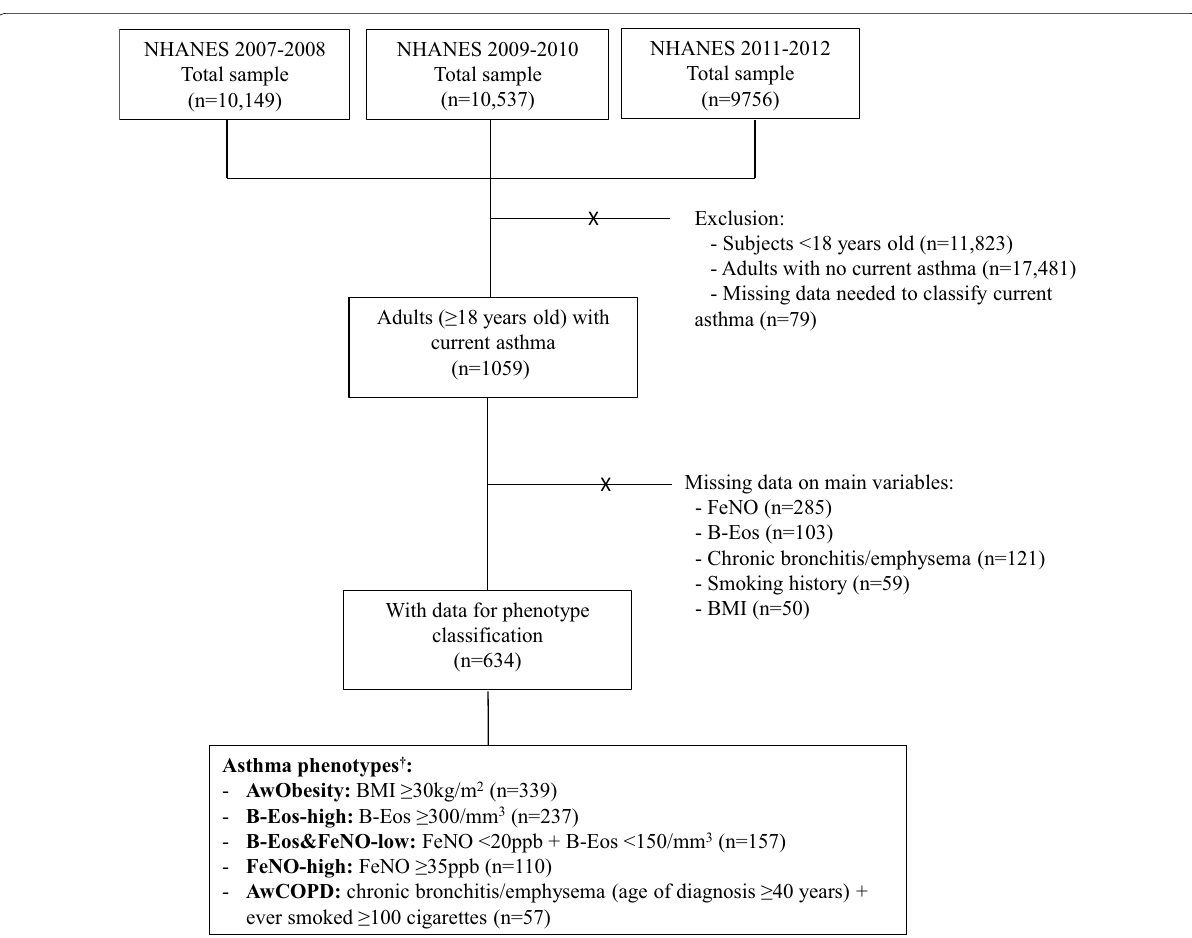
Fig. 1 Flowchart of the study analysis. † Seventy-seven patients were considered “non-classified” (non-single and non-multiple